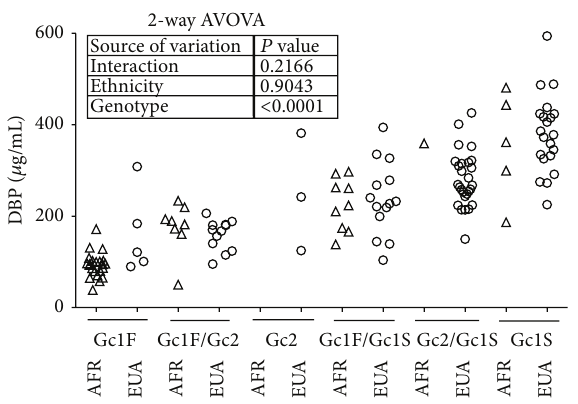
Figure 2: Serum vitamin D binding protein (DBP) concentration in patients with newly diagnosed pulmonary TB stratified by DBP Gc haplotype and ethnic group. Patients of Gc1F/1F haplotype had the lowest DBP concentrations and those with Gc1S/1S haplotype had the highest concentrations. Haplotypes frequency varied between ethnic groups of African ancestry (AFR) and Eurasian ancestry (EUA). The figure is adapted from Coussens et al.